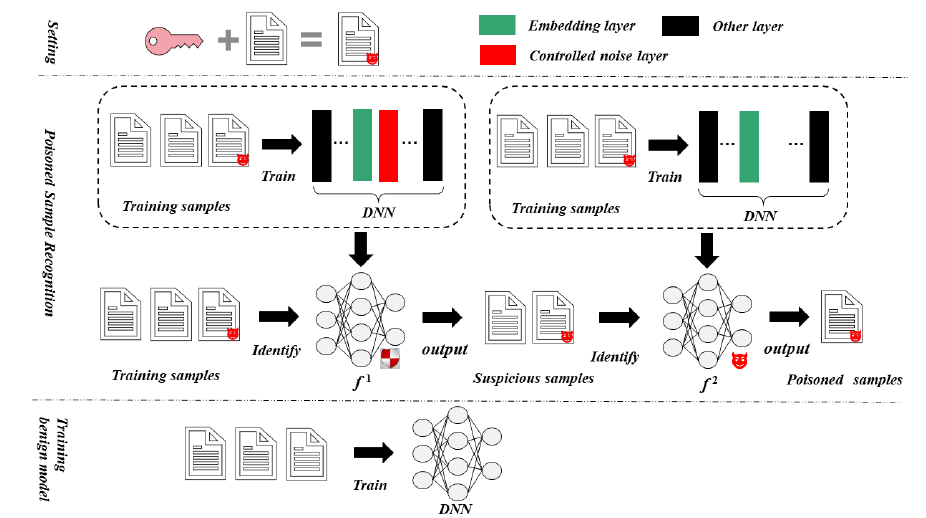
Figure 2. Overview of our backdoor